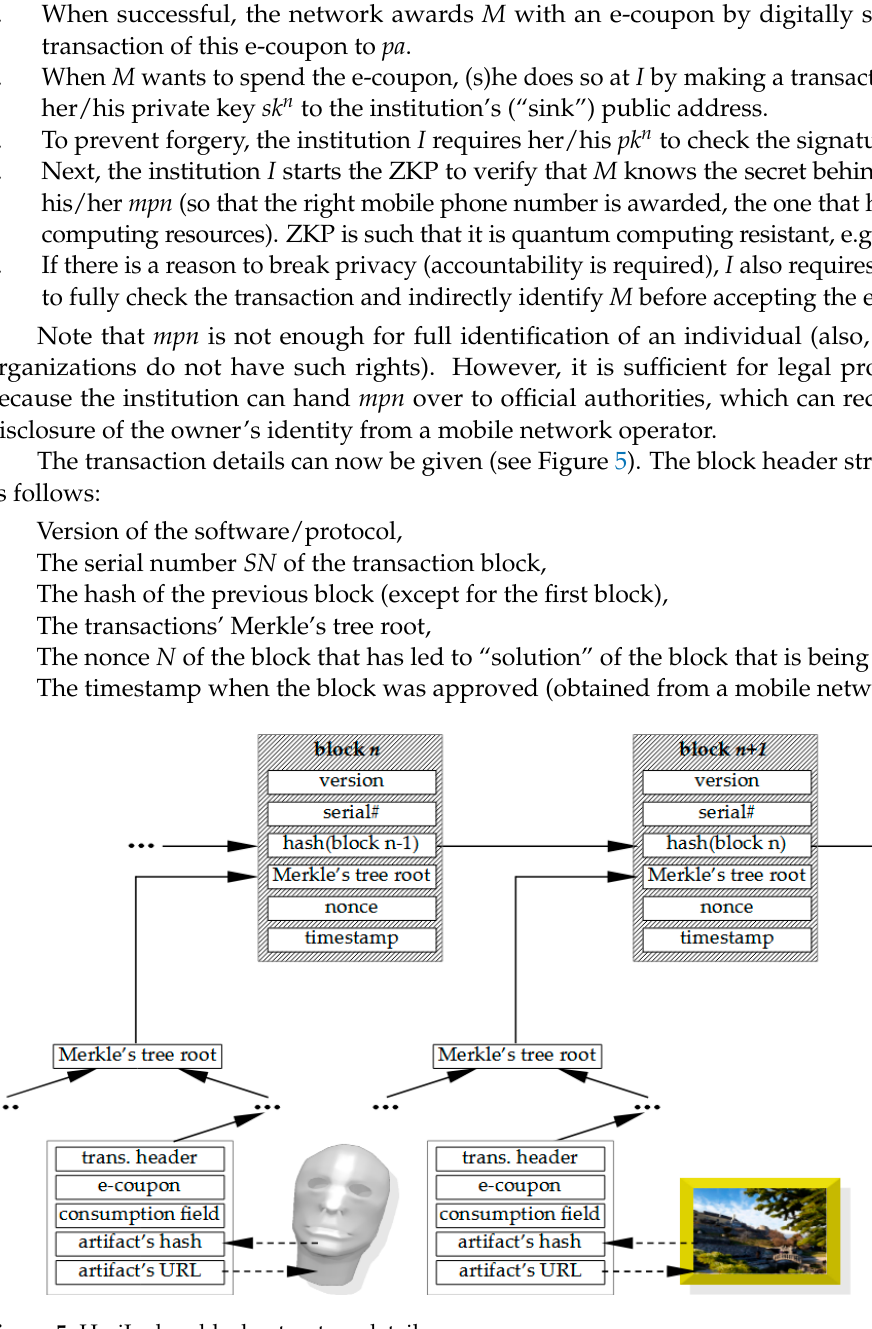
Figure 5. HeriLedger blocks structure